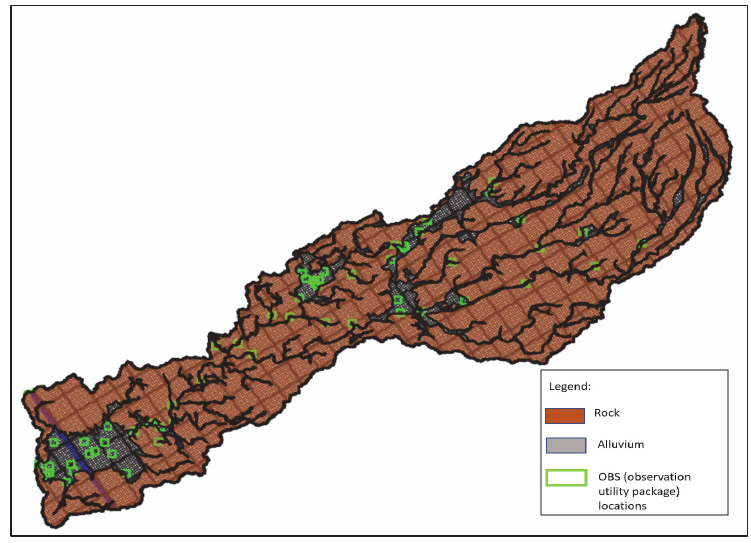
Figure 15. OBS (observation utility package) is located on existed observation well.